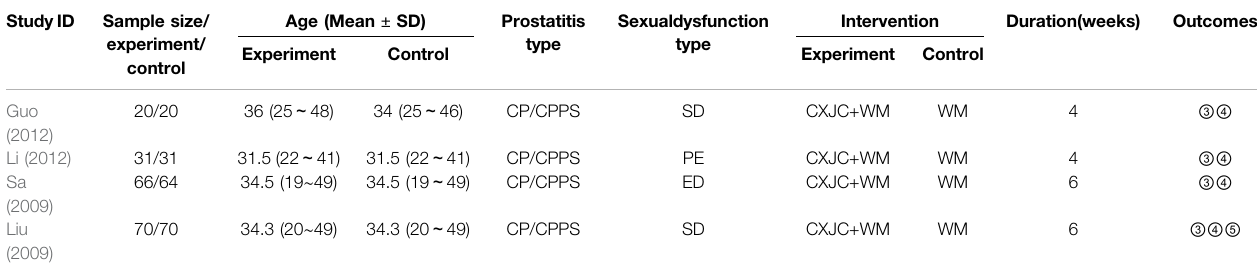
Frontiers in Pharmacology |